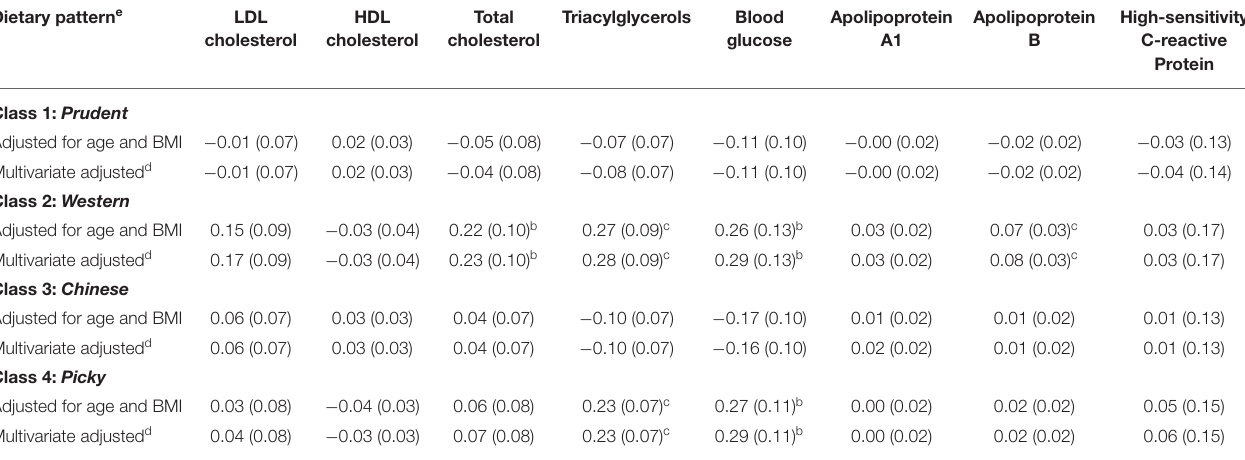
TABLE 3 | Association between dietary patterns (classes) and plasma lipid biomarkers, regression coefficients ( β ) a . Dietary pattern e LDL